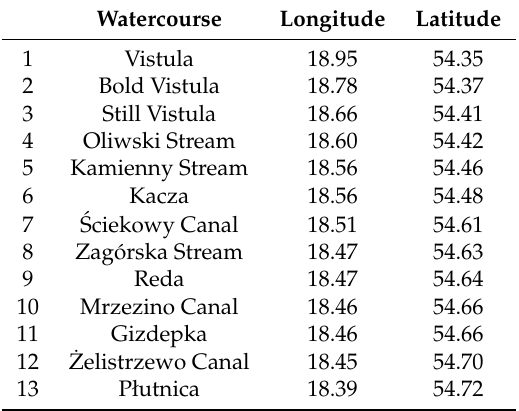
Table 2. Locations of mouths of watercourses included in the EcoPuckBay model